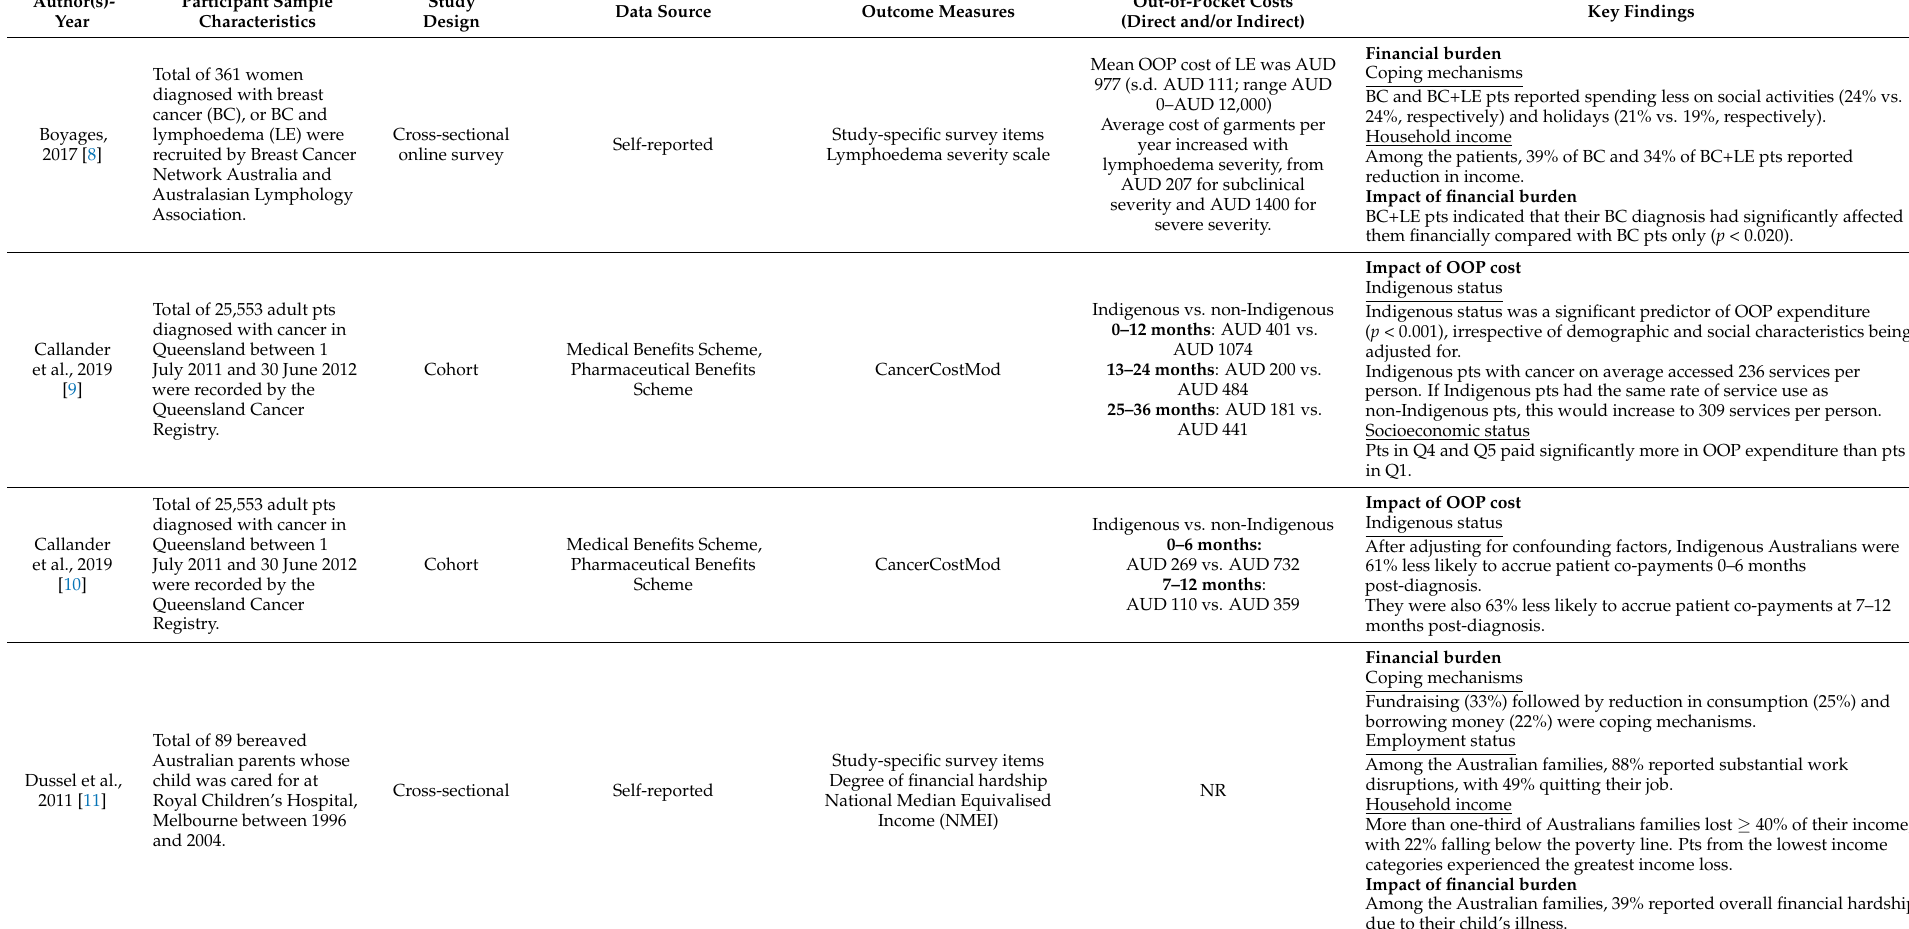
Table 1. Selected characteristics from included